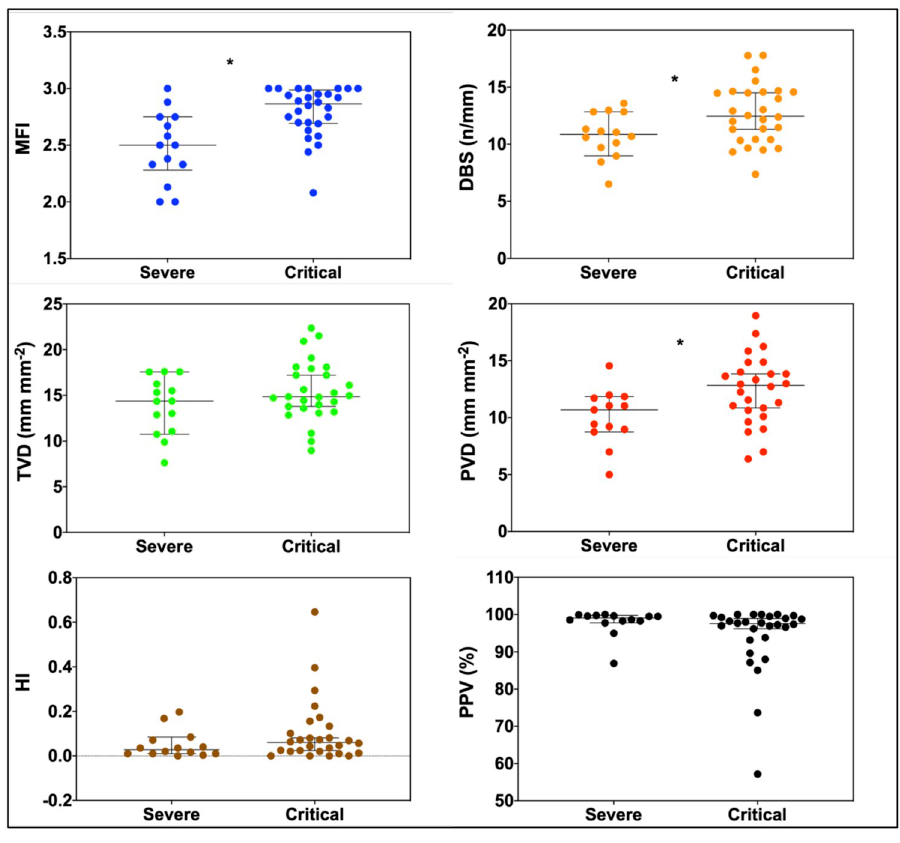
Fig 1. Comparisons of microcirculatory flow index (MFI), total vessel density (TVD), perfused vessel density (PVD), proportion of perfused vessel (PPV), De Backer score (DBS) and heterogeneity index (HI) in severe group and critical group. � : P value < 0.05 between groups comparisons using Mann-Whitney U